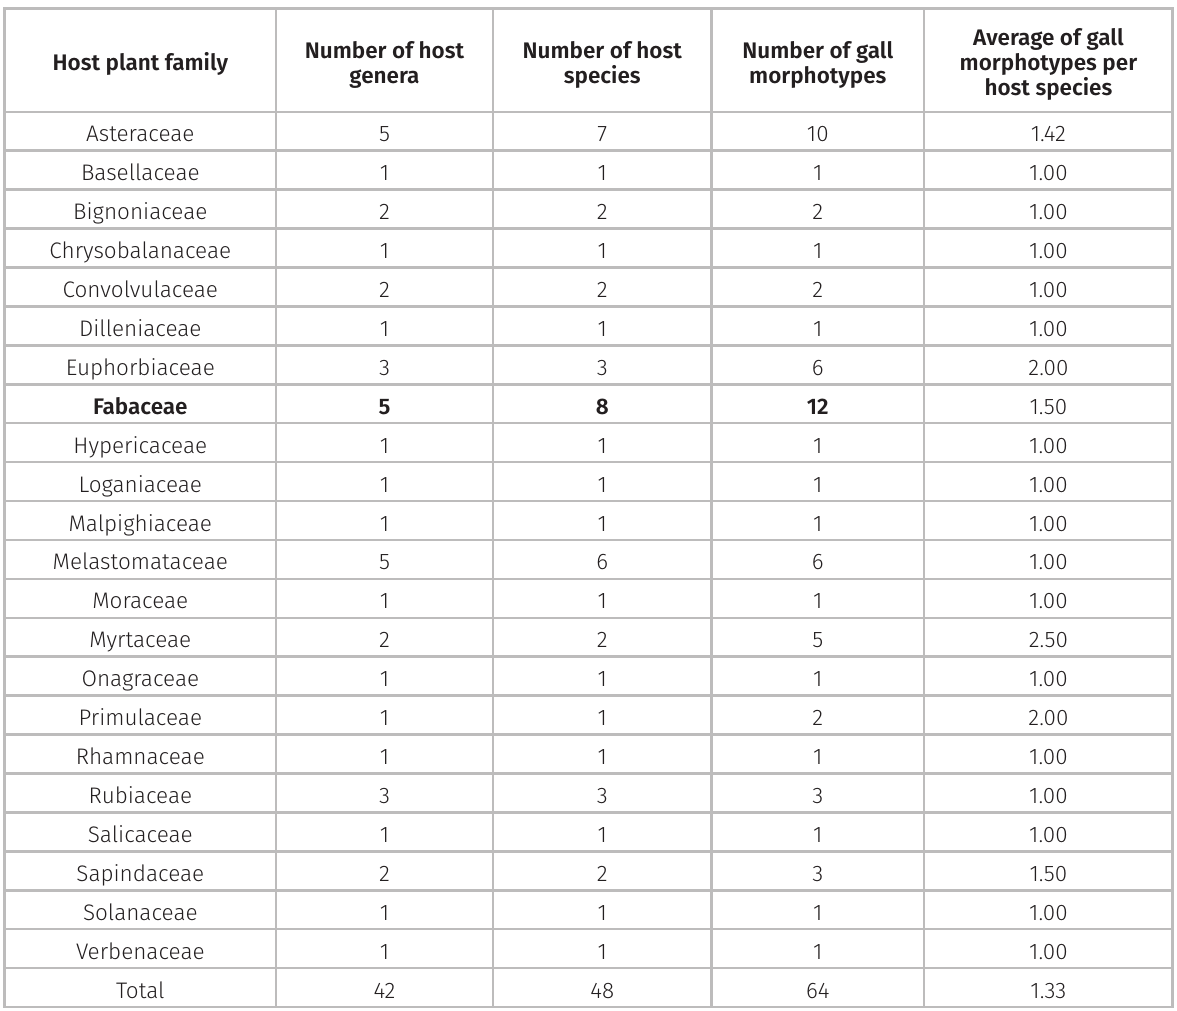
Table I. Richness of host genera, host species, gall morphotypes and host family in the Natural Heritage Private Reserve of Serra Negra do Funil (Minas Gerais,